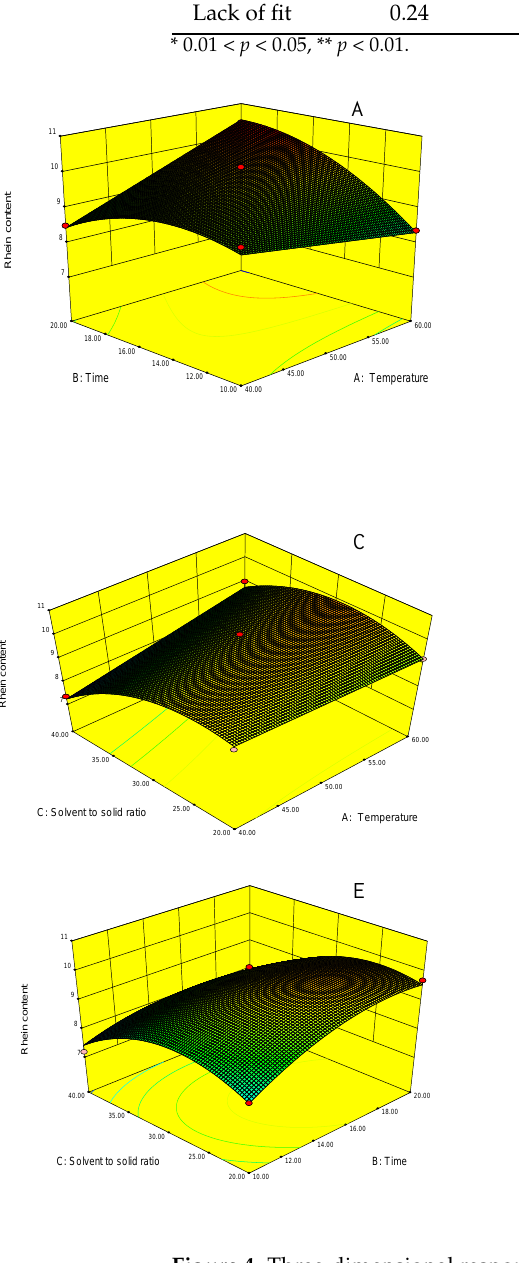
Figure 4. Three-dimensional response surface and contour plots: temperatures and extraction times ( A , B ), temperatures and solvent-to-solid ratios ( C , D ) and extraction times and solvent-to-solid ratios ( E , F ) on rhein content. Table 7. Predicted and actual values for the verification of optimal extraction conditions.